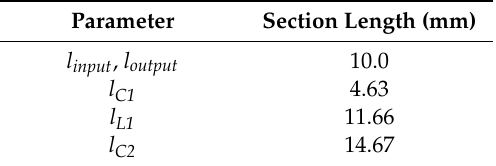
Table 3. Microstrip heterogeneous filter section length.